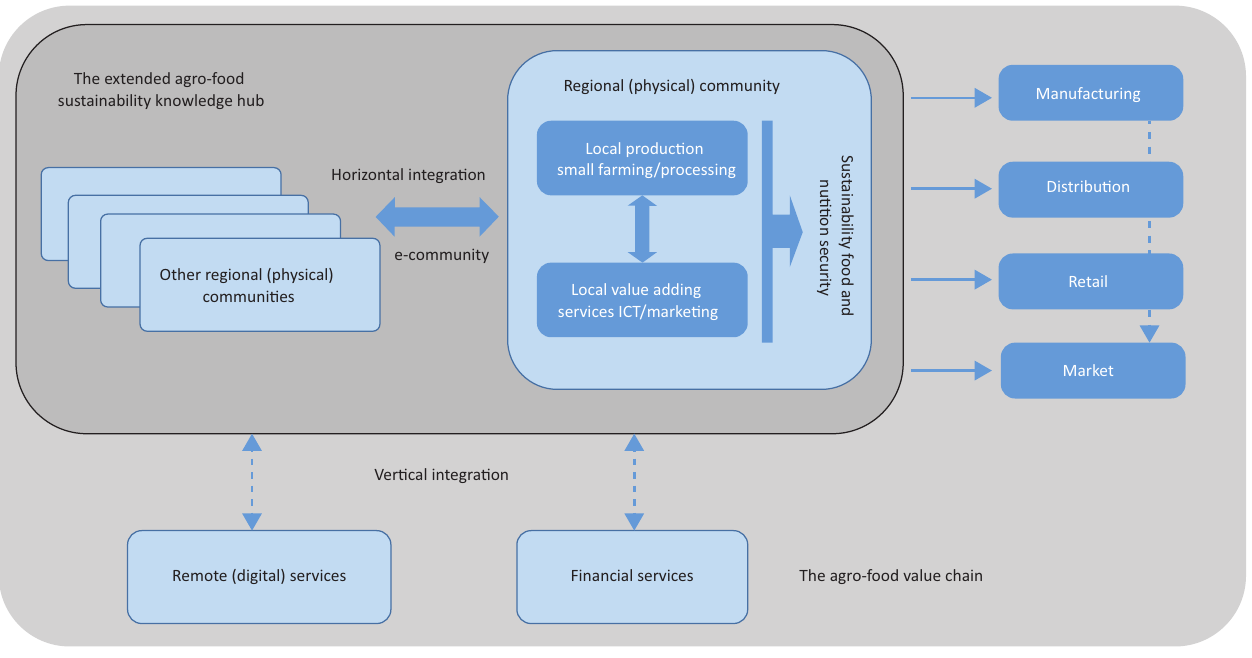
Source : Manikas, I.G., Malindretos, G. & Moschuris, S., 2019, ‘A community-based agro-food hub model for sustainable farming’, Sustainability 11(4), 1017. https://doi.org/10.3390/su11041017 FIGURE 5: A community-based Agro-Food Knowledge Hub.